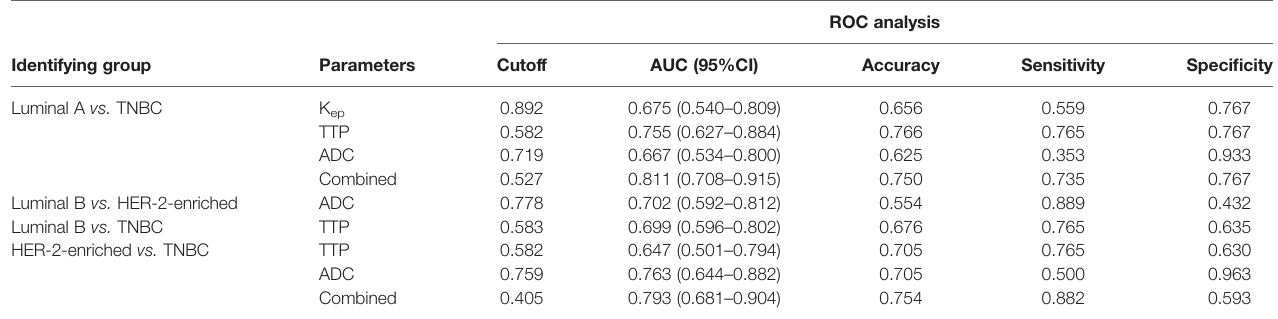
Combined indicate the predicted model based on the combination of the parameters. ROC, Receiver operating characteristic; AUC, Area underthe curve; CI, Con fi dence interval; TNBC, Triple-negative breast cancer; ADC, Apparent diffusion coef fi cient.